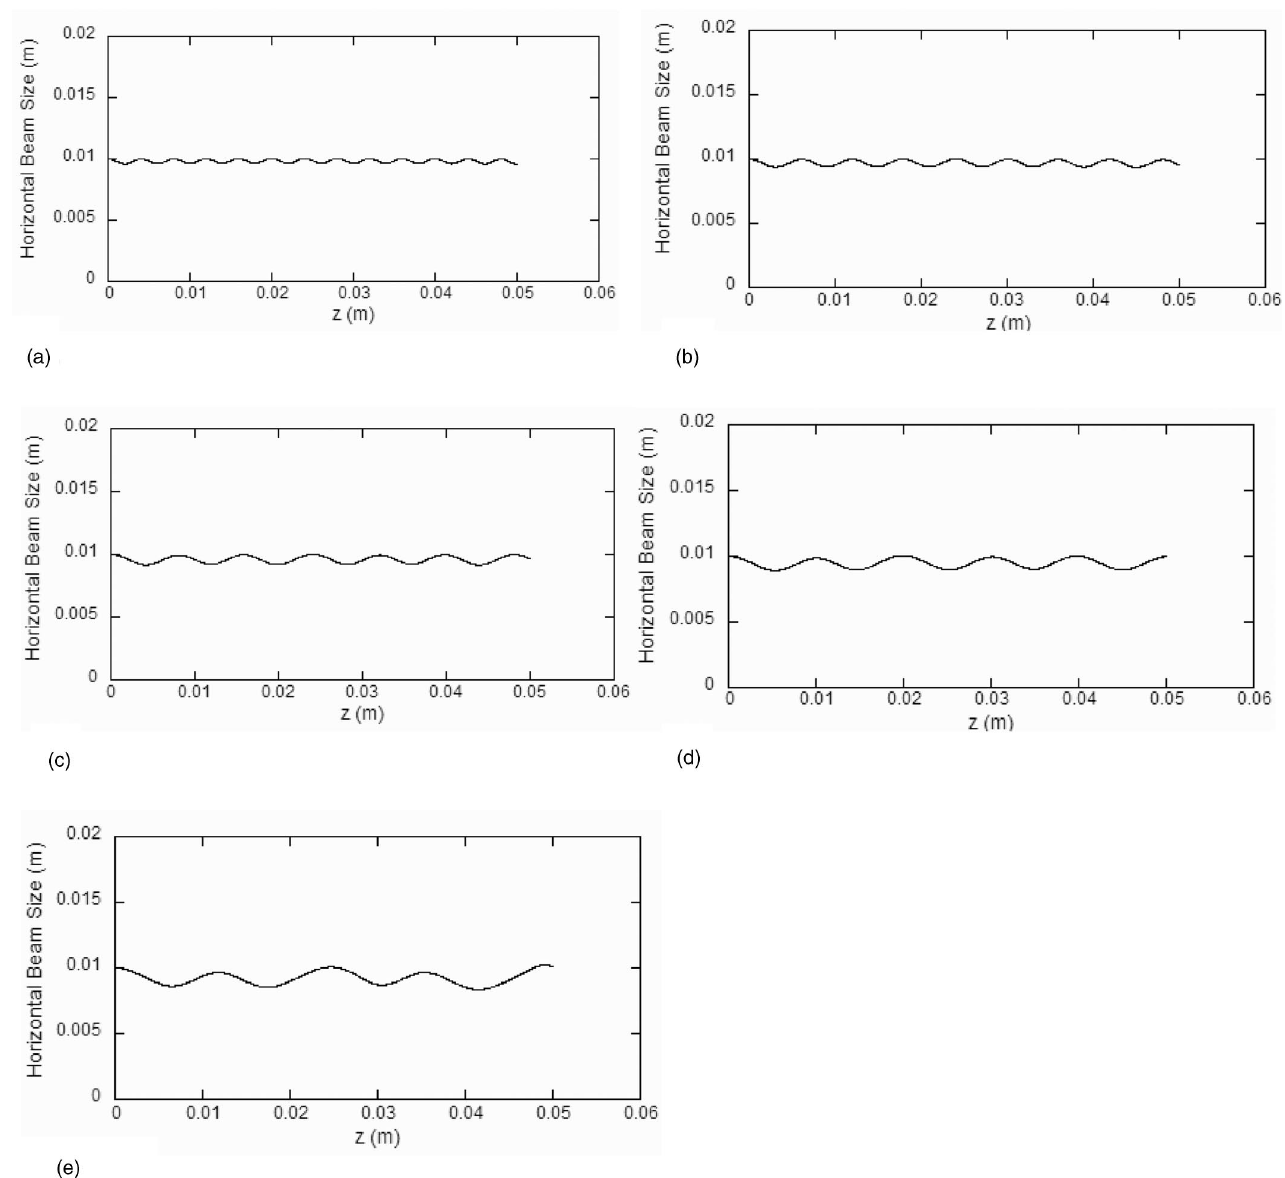
FIG. 15. Horizontal beam size for PPM focusing augmented by periodic quadrupole (a) 4-mm period, (b) 6-mm period, (c) 8-mm period, (d) 10-mm period, and (e) 12-mm period.